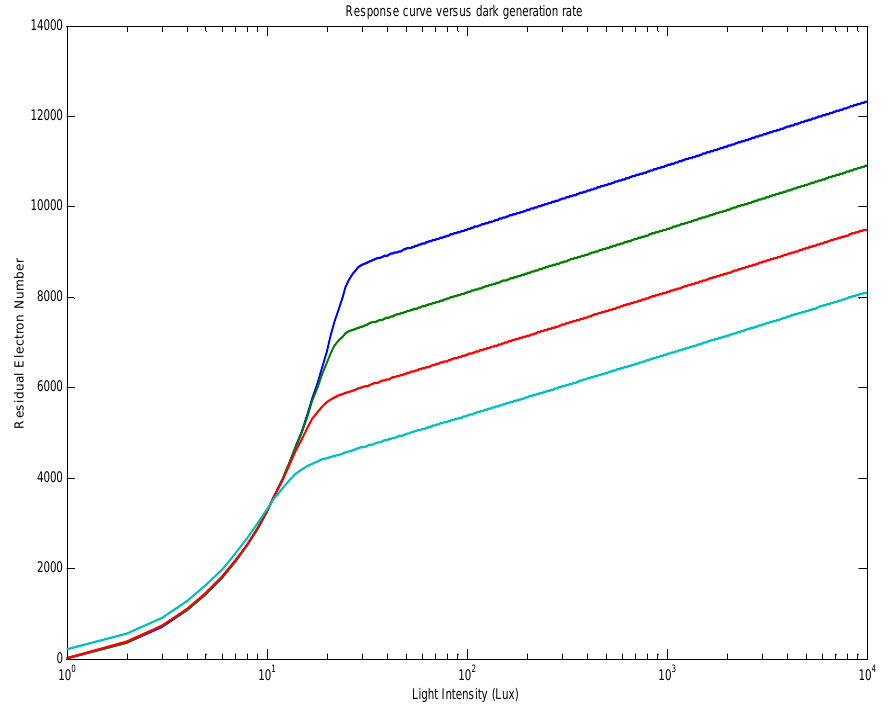
Figure 4. Response curves for different dark generation rates (10 e/s, 100 e/s, 1000 e/s, and 10,000 e/s in order from top to bottom). The same buried photodiode parameters as in Figure 3 have been used. The linear–logarithmic transition points match well the values calculated from Equation (6).